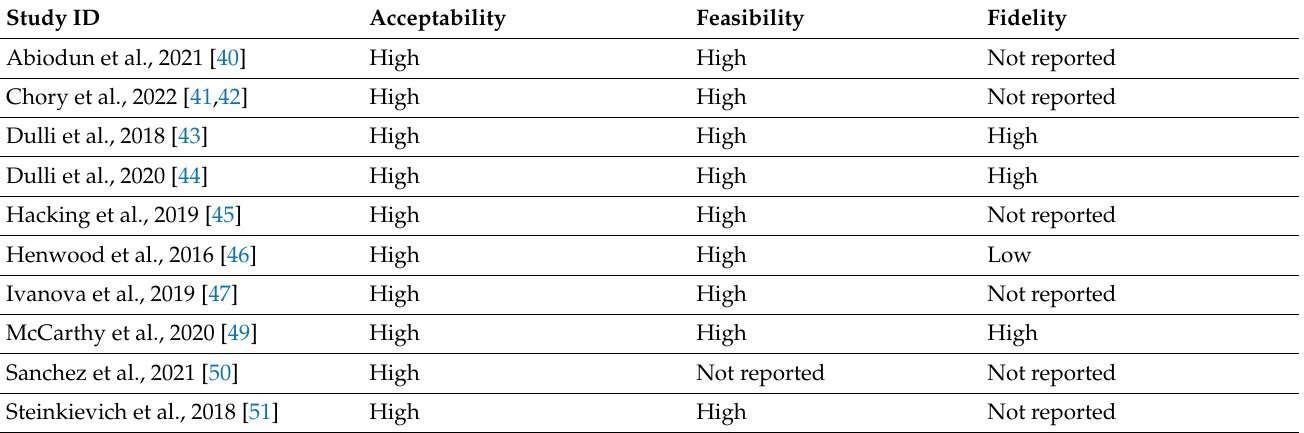
Table 6. Summary of secondary